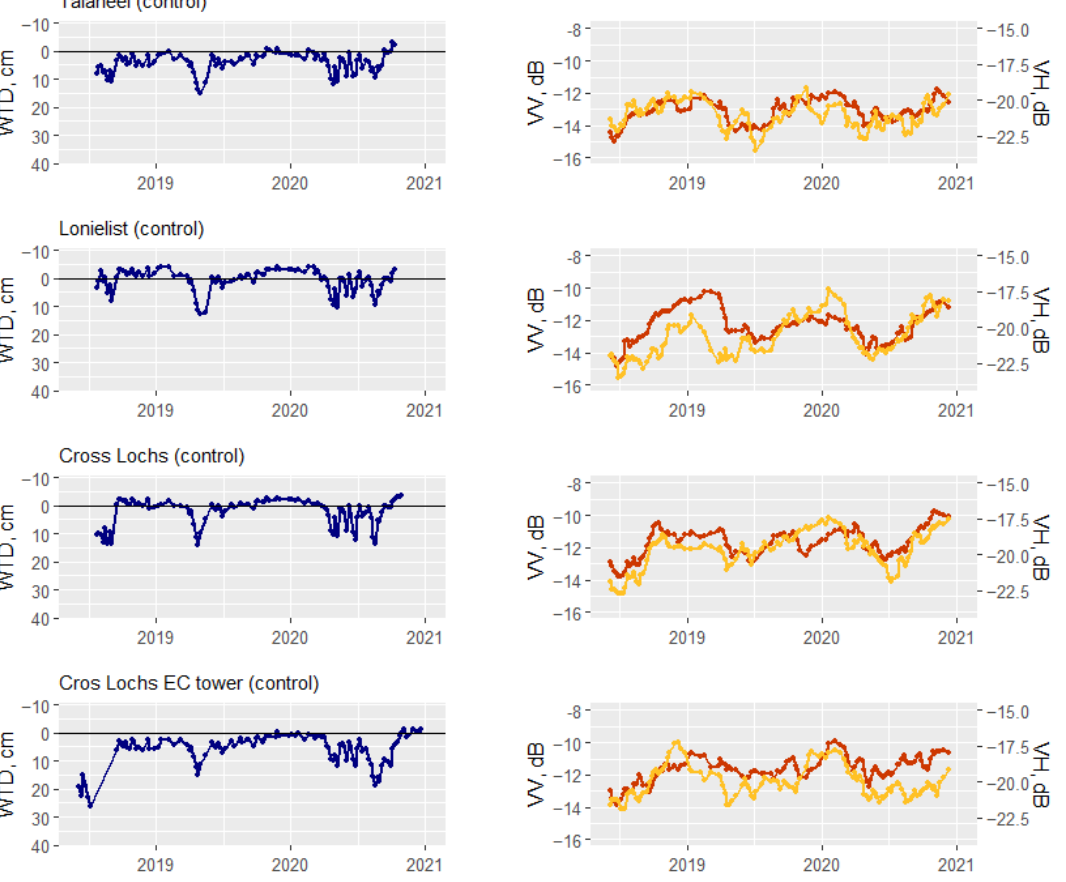
Figure 3. Observed water table depth ( left ) and Sentinel-1 (( right ); VV in red, VH in yellow) backscatter time series for near-natural peatland sites in Forsinard Flows area. The black horizontal line indicates the ground surface.